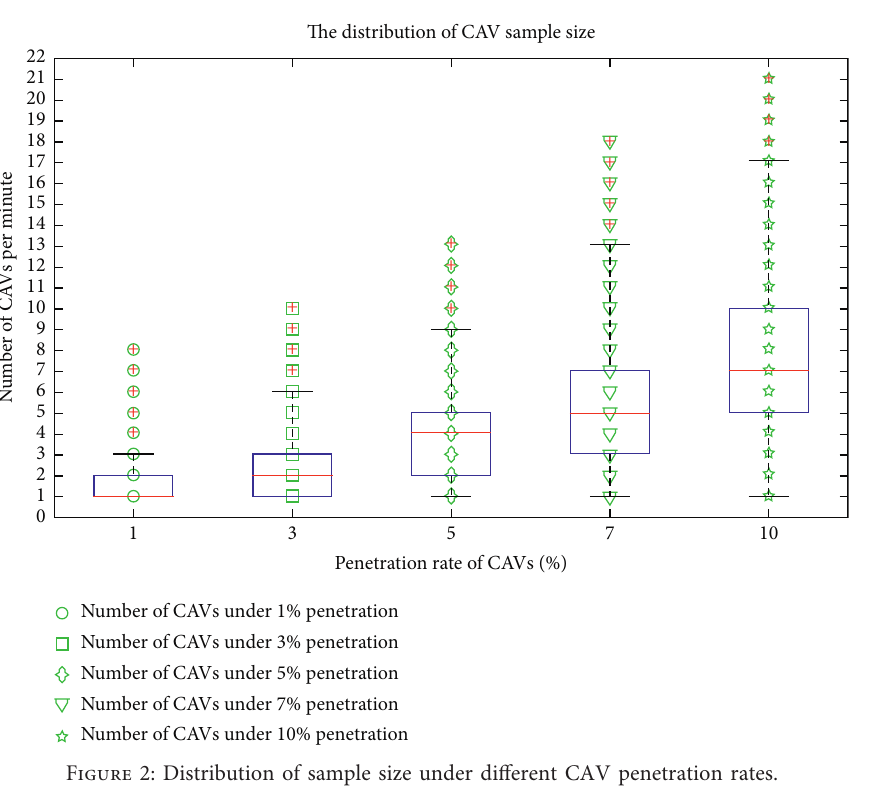
Figure 2: Distribution of sample size under different CAV penetration